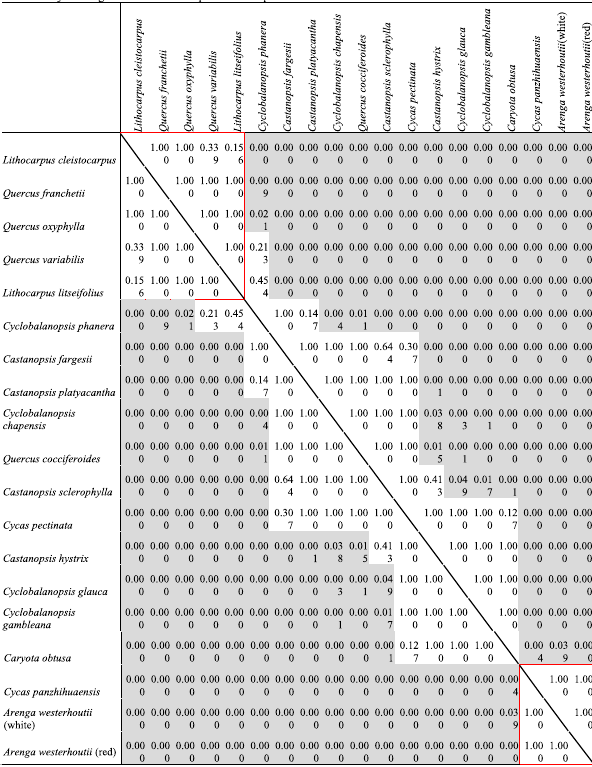
hystrix ( Figure 2 : 2) and C. fargesii ( Figure 2 : 3) also have a high percentage of normal polygonal